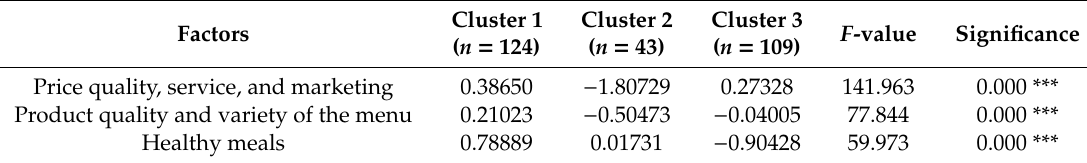
Table 5. Final cluster centers.